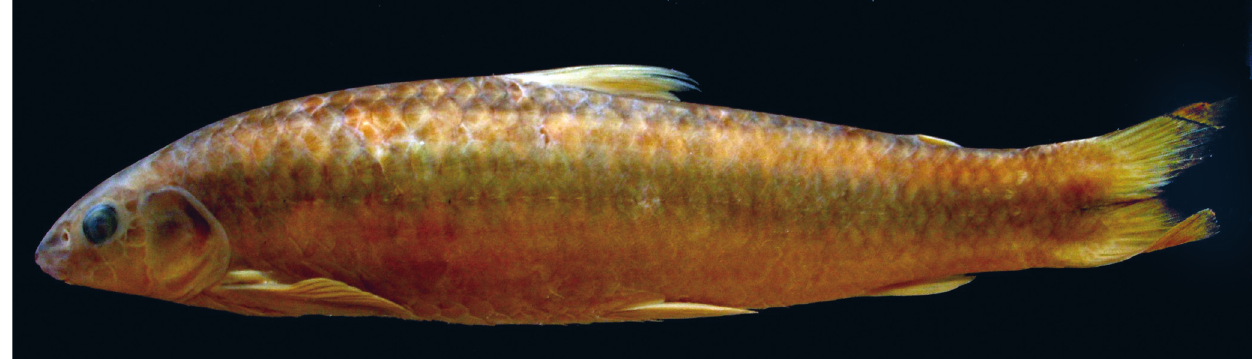
Fig. 5. Parodon buckleyi , IUQ 977, 131.2 mm SL, Colombia, Inchiyaco River above Villa Garzón-San José del Fragua road,